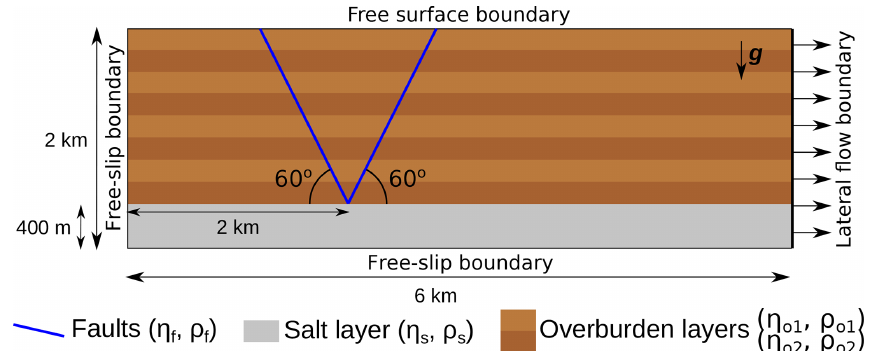
Figure 11. Setup of the simulation for the simplified graben model. The initial particle swarm is densified near the faults and at the interface between salt and sediment.